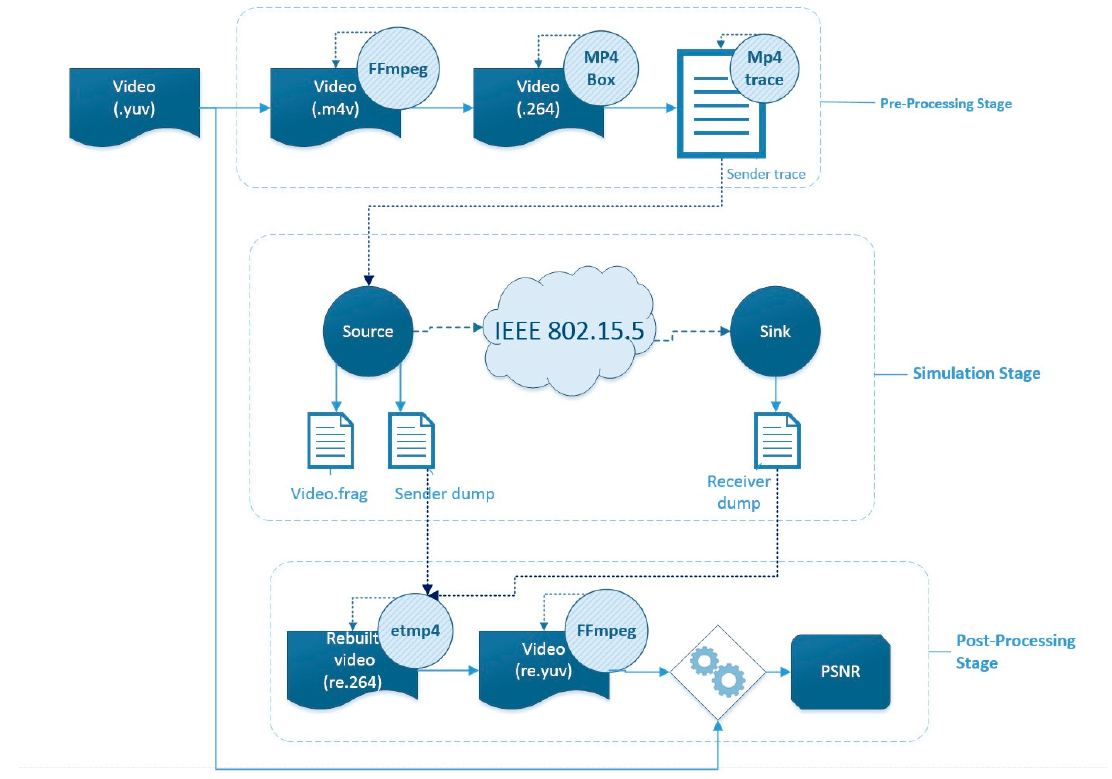
Figure 6. Simulation workflow. Table 3. Sender trace file structure.